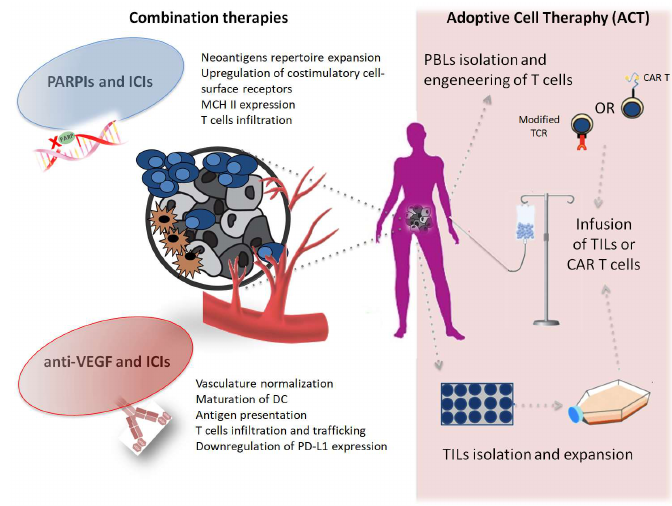
Figure 1. Representative scheme of combination therapies approaches and adoptive cell therapy (ACT) in OC.